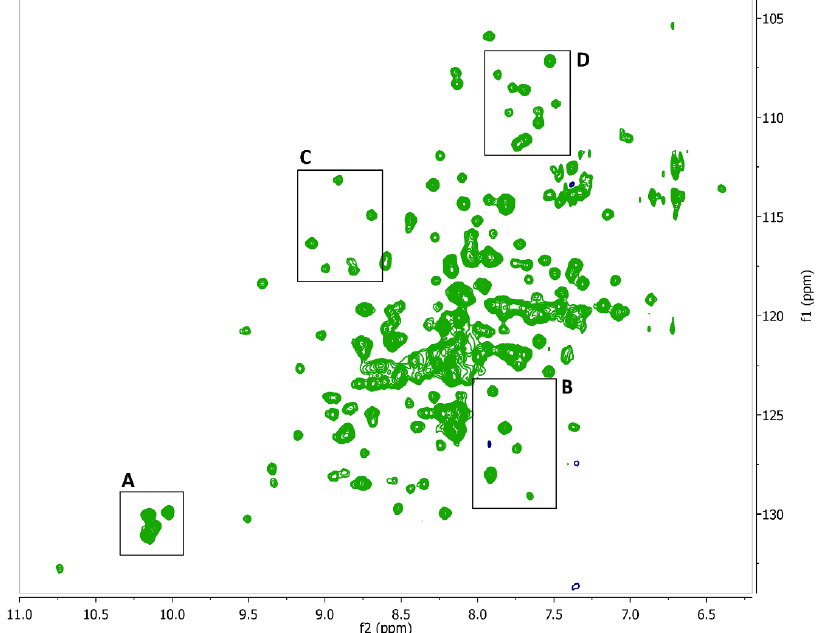
Figure 5. 1 H- 15 N HSQC spectrum of the periplasmic domain of FtsQ. The five tryptophan residues give clear distinguishable signals at a 10–11 ppm shift. Area’s ( A – D ) show the portions of the spectrum from which the zooms showing chemical shifts perturbations were taken, as shown in Figure 6.